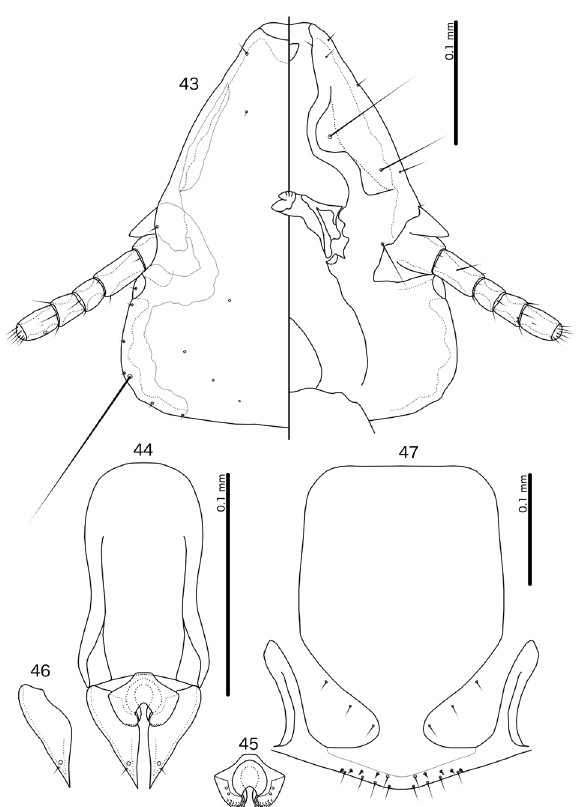
Figures 43–47. Brueelia ferianci Balát, 1955, ex Anthus triv- ialis (Linnaeus, 1758) 43 Male head, dorsal and ventral views 44 Male genitalia, dorsal view 45 Male mesosome, ventral view 46 Male paramere, dorsal view 47 Female subgenital plate and vulval margin, ventral